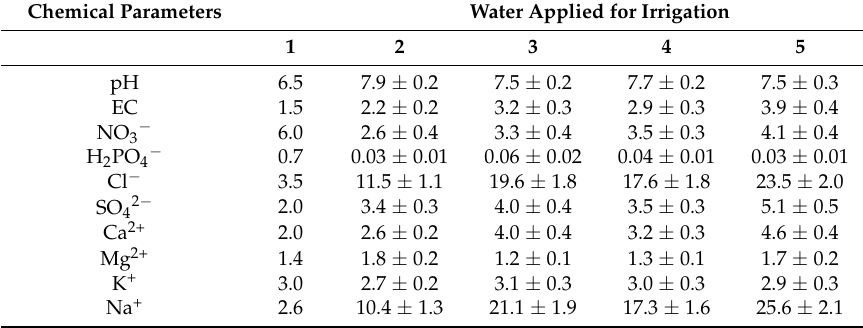
Table 1. Chemical composition of the applied water. Electrical conductivity (EC) was expressed in dS m − 1 and nutrient concentration in mmol L − 1 . Water number 1: standard nutrient solution; number 2: blend of tap water and drainage from irrigation of Ra with nutrient solution used to irrigate Ms ; number 3: drainage from irrigation of Ms irrigated with water number 2 used to irrigate Ja ; number 4: drainage from irrigation of Ra with nutrient solution used to irrigate Ms , and number 5: drainage from irrigation of Ms irrigated with water number 4 used to irrigate Ja . Data are the means ± standard deviation of four samples per treatment. For water numbers 2–5, the values are the average values of the different chemical parameters analyzed weekly during the trial. Chemical